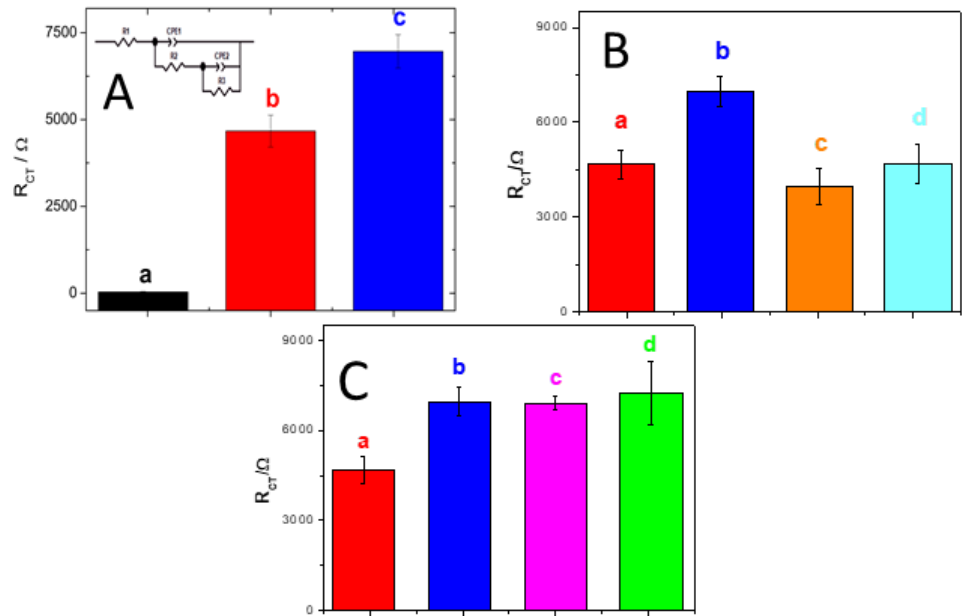
Figure 5. ( A ) Bar plot for the R ct of the redox marker obtained after the different steps during the construction of the genosensors and subsequent hybridization: GCE/MWCNTs ‐ PolyArg (a), GCE/MWCNTs ‐ PolyArg/oligo 21 (b), and GCE/MWCNTs ‐ PolyArg/oligo 21 in the presence of 1.0 × 10 − 13 M miRNA ‐ 21 (c). The inset shows the corresponding equivalent circuit. ( B ) Bar plots for R ct of the redox marker obtained at: a) GCE/MWCNTs ‐ PolyArg/oligo 21 in the absence (a) and in the presence of 1.0 × 10 − 13 M miRNA ‐ 21 (b); 1.0 × 10 − 13 M fully non ‐ complementary sequence (c); 1.0 × 10 − 13 M one ‐ base mismatch sequence (d). ( C ) Bar plots for R ct of the redox marker obtained at GCE/MWCNTs ‐ PolyArg/oligo 21 in the absence (a) and presence of 1.0 × 10 − 13 M miRNA ‐ 21 (b); serum 1/1000 enriched with 1.0 × 10 − 13 M miRNA.21 (c); urine diluted 1/10 enriched with 1.0 × 10 − 13 M miRNA ‐ 21 (d). Redox marker: 1.0 × 10 − 3 M HQ/Bz solution; EIS parameters: amplitude, 0.010 V, frequency range, 1.0 × 10 − 2 to 1.0 × 10 6 Hz, working potential, 0.200 V.